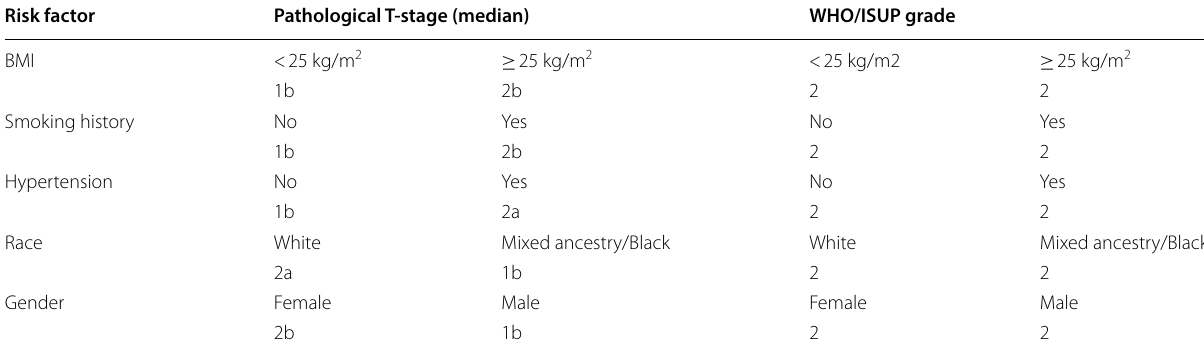
Table 2 Relationship between risk factors and pathological stage and grade Risk factor Pathological T-stage (median)